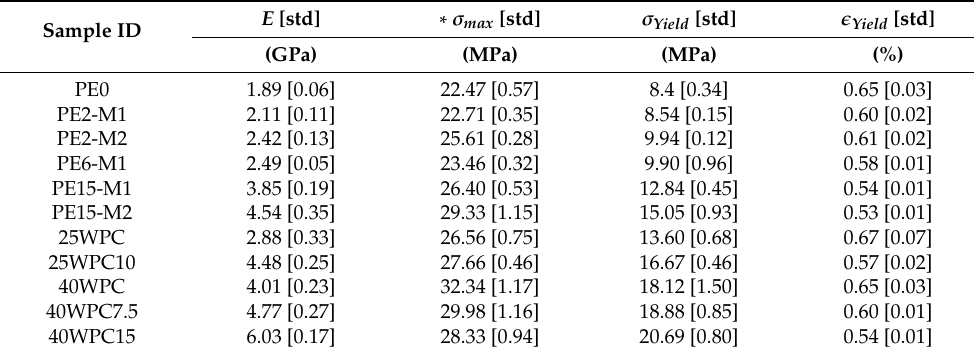
Figure 2. Tensile stress–strain curves of ( a ) nanocomposites, and ( b ) wood polymer composites. Colored version of the graphs can be found online. Table 4. Tensile properties of the nanocomposites and WPCs.